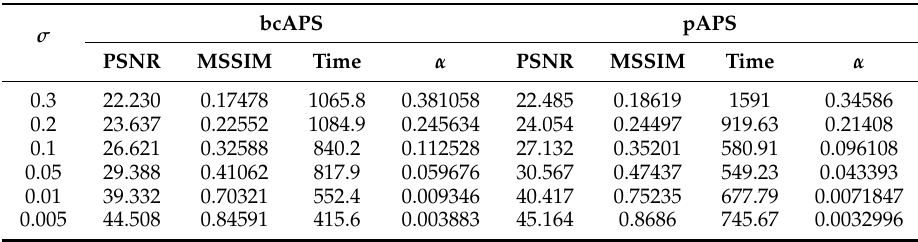
Table 14. PSNR- and MSSIM-values of the reconstruction of the cameraman-image corrupted by Gaussian white noise with standard deviation σ via the bcAPS algorithm using the primal-dual Newton method with η = 0.